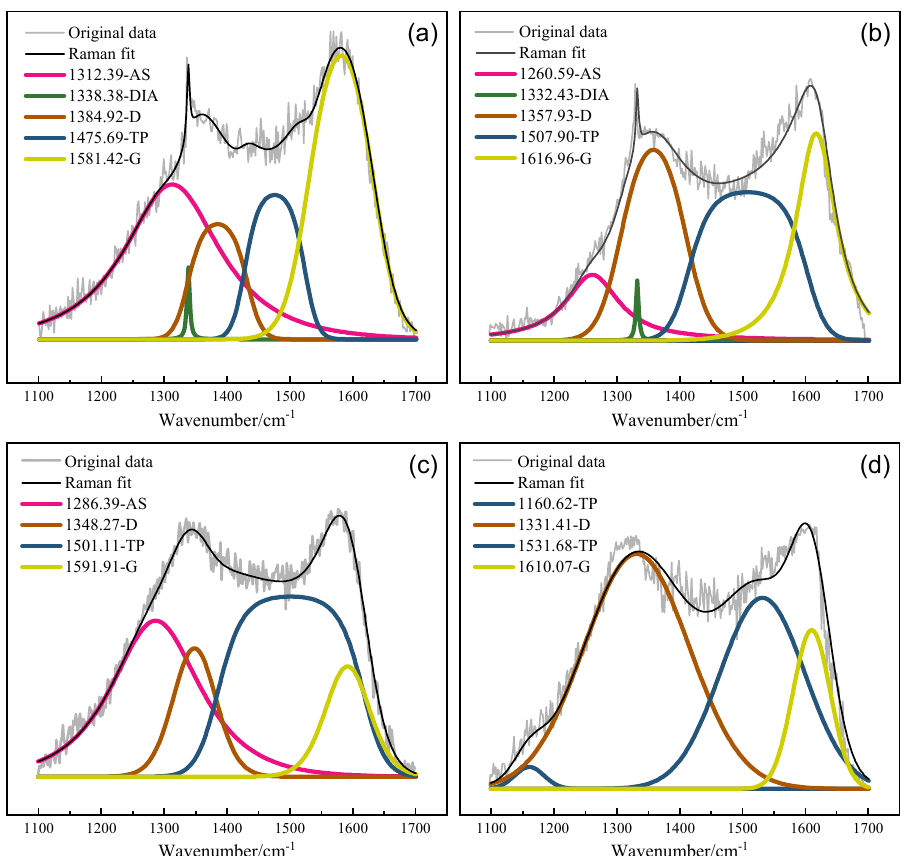
Figure 8. Raman spectra of the diamond coatings irradiated under different pulse energies. ( a ) 50 μ J, ( b ) 70 μ J, ( c ) 80 μ J, and ( d ) 100 μ J.